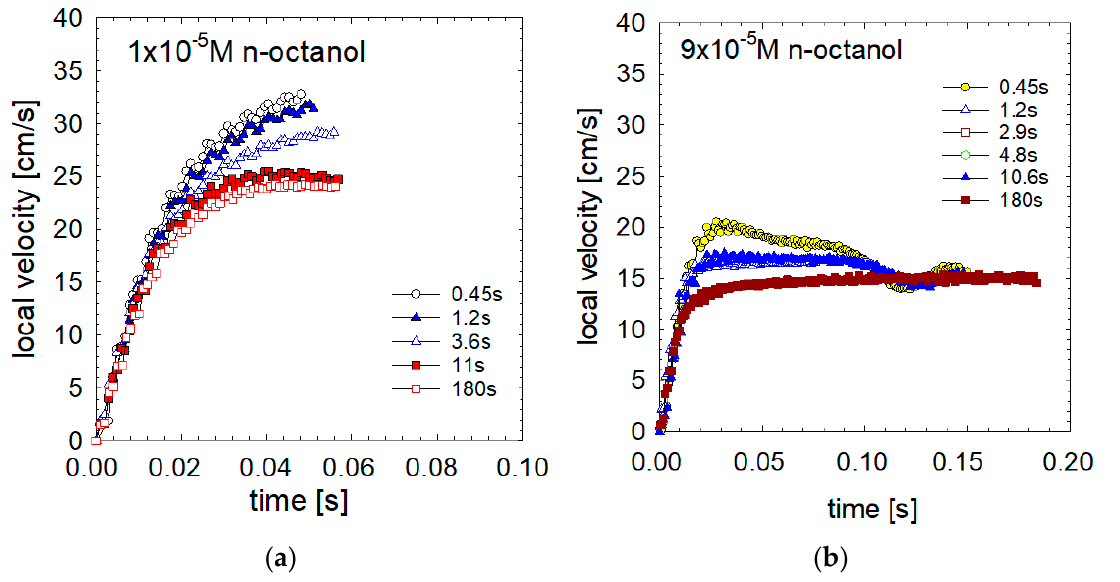
Figure 6. Detailed velocity profiles for acceleration stage of motion) in ( a ) 1 × 10 − 5 M and ( b ) 9 × 10 − 5 M n-octanol solution as a function the detachment time.